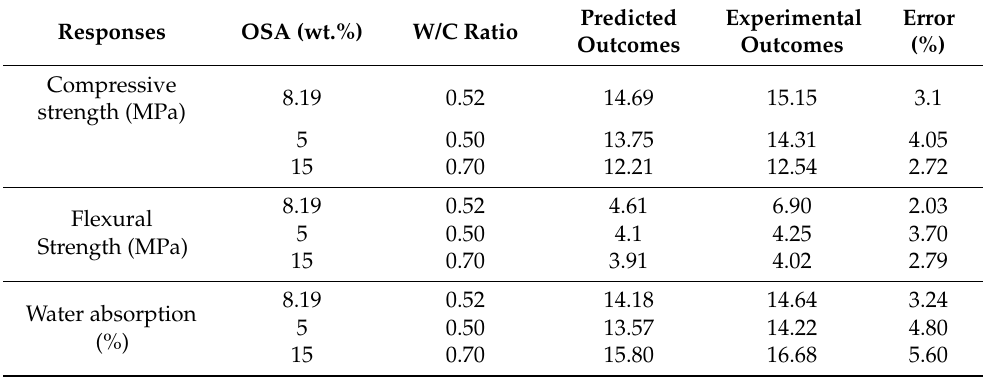
Table 9. Model Table 9. Model validation.